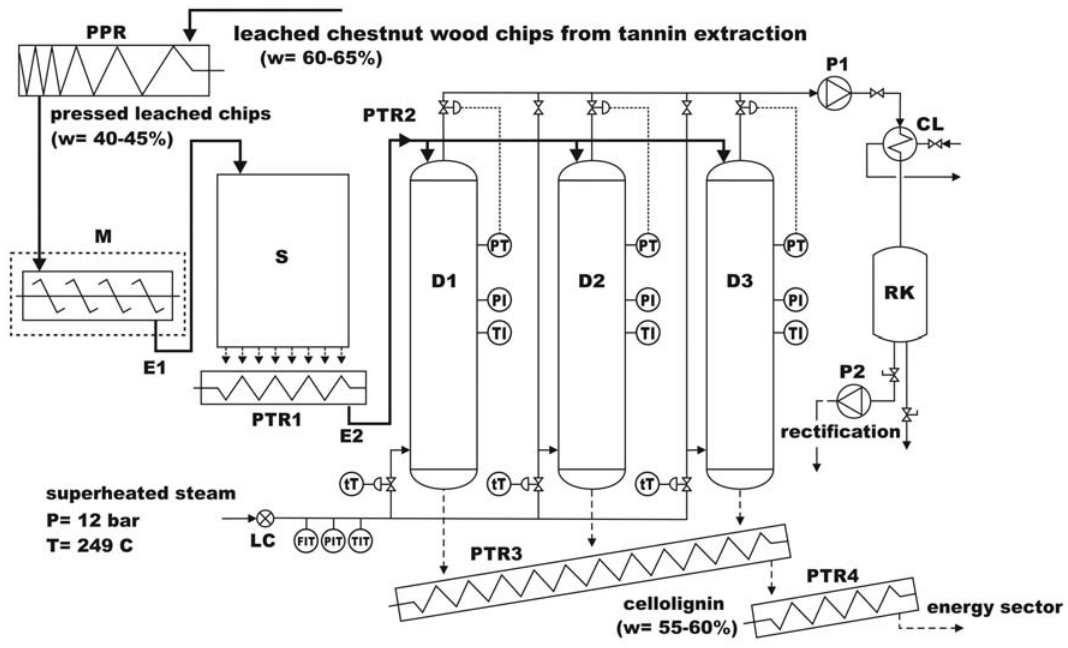
Figure 1. Process scheme of the industrial non-catalysed furfural production plant. Legend: PPR – press, M – mixer for catalyst application onto the wood particles (in preparation), S – silo, E1 and E2 – elevators, PTR1, PTR2, PTR3 and PTR4 – conveyors, D1, D2, D3 – reaction vessels, P1, P2 – pumps, CL – cooling line, RK – reservoir for reaction condensate, LC – steam condensate remover, FIT – steam flow rate indicator and transmitter, PI – pressure indicator, PIT – pressure indicator and transmitter, PT – pressure transmitter, tT – time transmitter, TI – temperature indicator, TIT – temperature indicator and